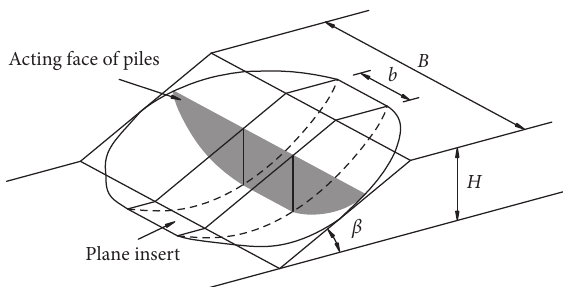
Figure 2: 3D failure mechanism with the plane